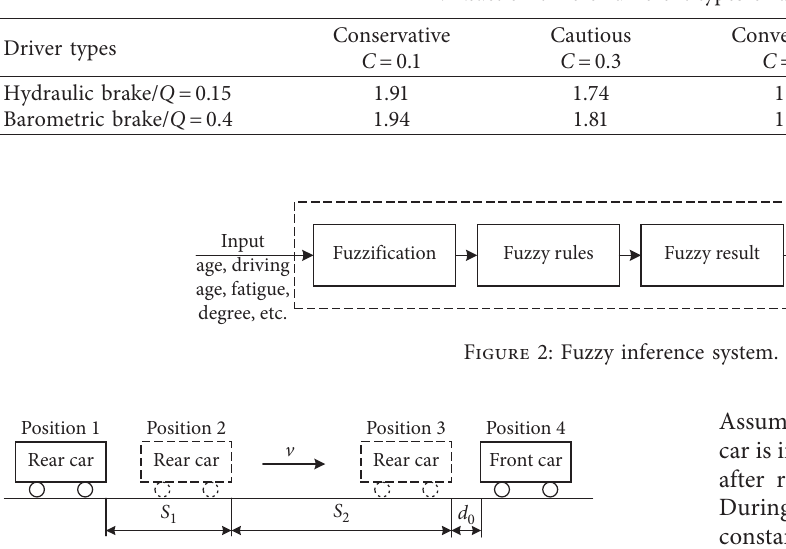
Figure 3: Positional relationship (in the static state of the front